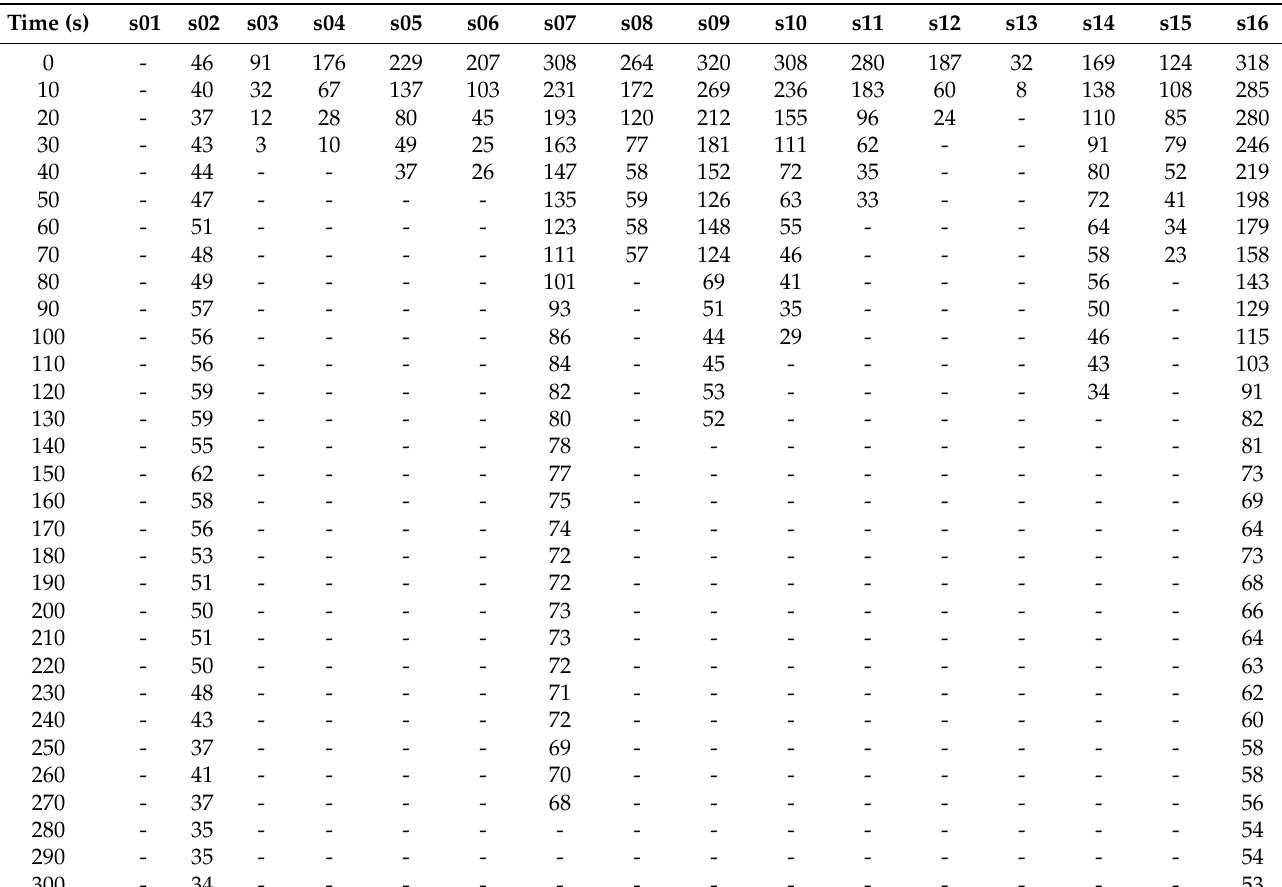
Table 1. Height of foam (pixels) determined by performing image analysis on RGB videos of 16 beer samples (the actual value in mm can be obtained using the conversion 1 mm = 6.6 px).